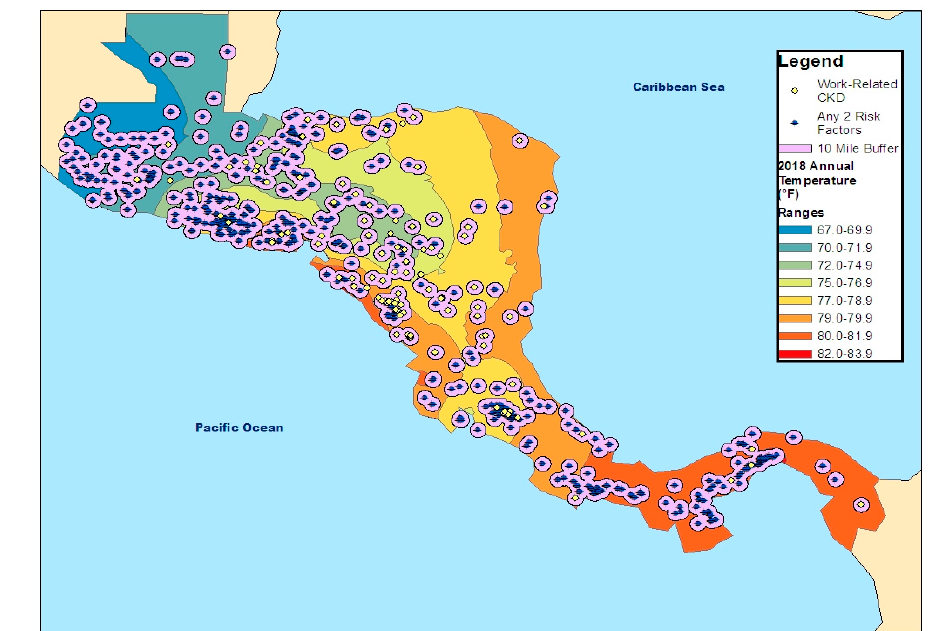
Figure 1. Geographic distributions of work-related CKD cases and CKDu risk factors (high temperature, high humidity, high physical demands).